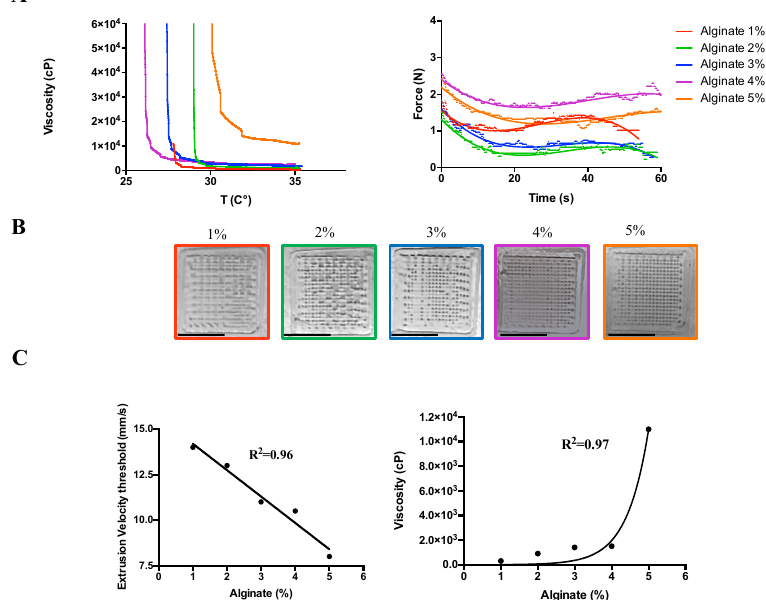
Figure 1. Three-dimensional bioprinting process parameters. ( A ) Left: hydrogel viscosity calculated at different sodium alginate (SA) concentrations for different extrusion temperatures (25–37 ◦ C). Right: extrusion force measured for the different SA at 35 ◦ C. ( B ) Preserved geometry at different SA: from left to right: 1, 2, 3, 4 and 5%. Scale Bar: 10 mm. ( C ) Left: minimal extrusion speed threshold able to preserve the geometry in ( B ) at different SA concentrations. Right: hydrogel viscosity calculated at the minimal extrusion speed for the different SA concentrations at 35 ◦